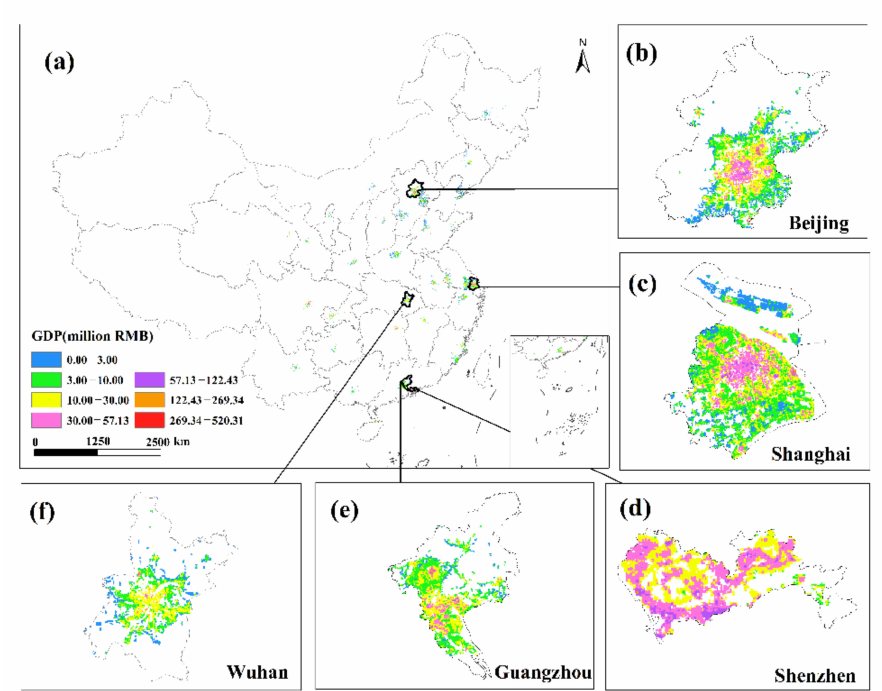
Figure 10. The spatial distribution of the total GDP of the secondary and tertiary industries in March 2020. ( a ) The spatial distribution of the total GDP in 34 Chinese cities; ( b ) Beijing; ( c ) Shanghai; ( d ) Shenzhen; ( e ) Guangzhou; ( f ) Wuhan.